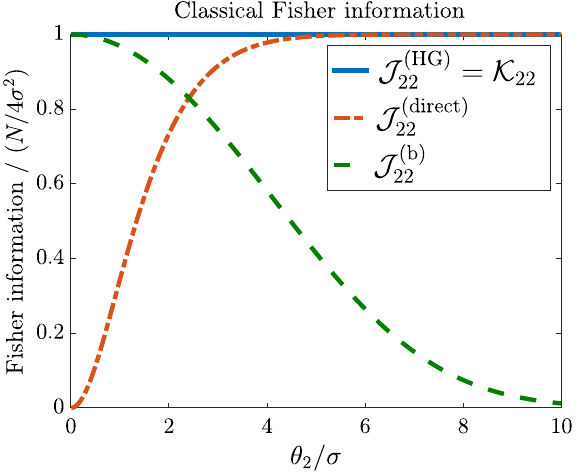
FIG. 9. Fisher information for separation estimation versus normalized separation θ 2 =W for the sinc point-spread function. K J ð direct Þ 22 is the quantum value, 22 is the numerically computed value for direct imaging, and J ð b Þ 22 is that for binary SPADE tailored for the sinc function. The vertical axis is normalized with respect to K 22 ¼ π 2 N= ð 3 W 2 Þ